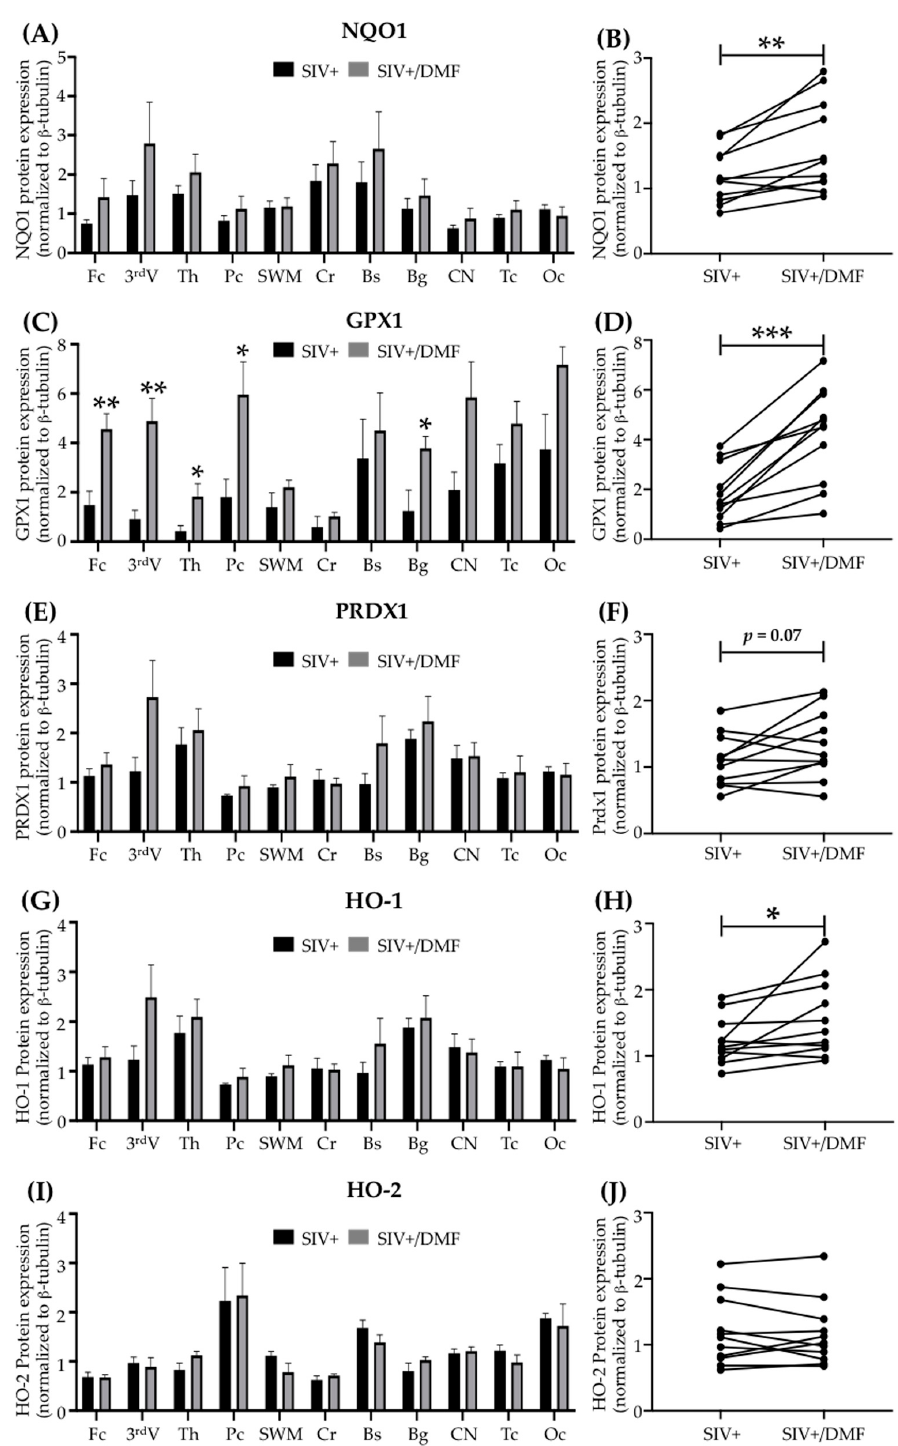
Figure 4. DMF treatment was associated with higher antioxidant enzyme expression in the brains of SIV-infected macaques. ( A ) No significant difference in NQO1 expression was observed in the individual regions using Student’s unpaired t -test (Fc: frontal cortex, 3 rd V: third ventriculi, Th: thalamus, Pc: parietal cortex, SWM: subcortical white matter, Cr: cerebellum, Bs: brainstem, Bg: basal ganglia, CN: caudate nuclei, Tc: temporal cortex, Oc: occipital cortex). ( B ) A significant increase in overall mean NQO1 expression was observed with DMF treatment (paired t -test). ( C ) A significant increase in GPX1 expression was observed in the Fc, 3 rd V, Th, Pc, and Bg with DMF treatment. ( D )